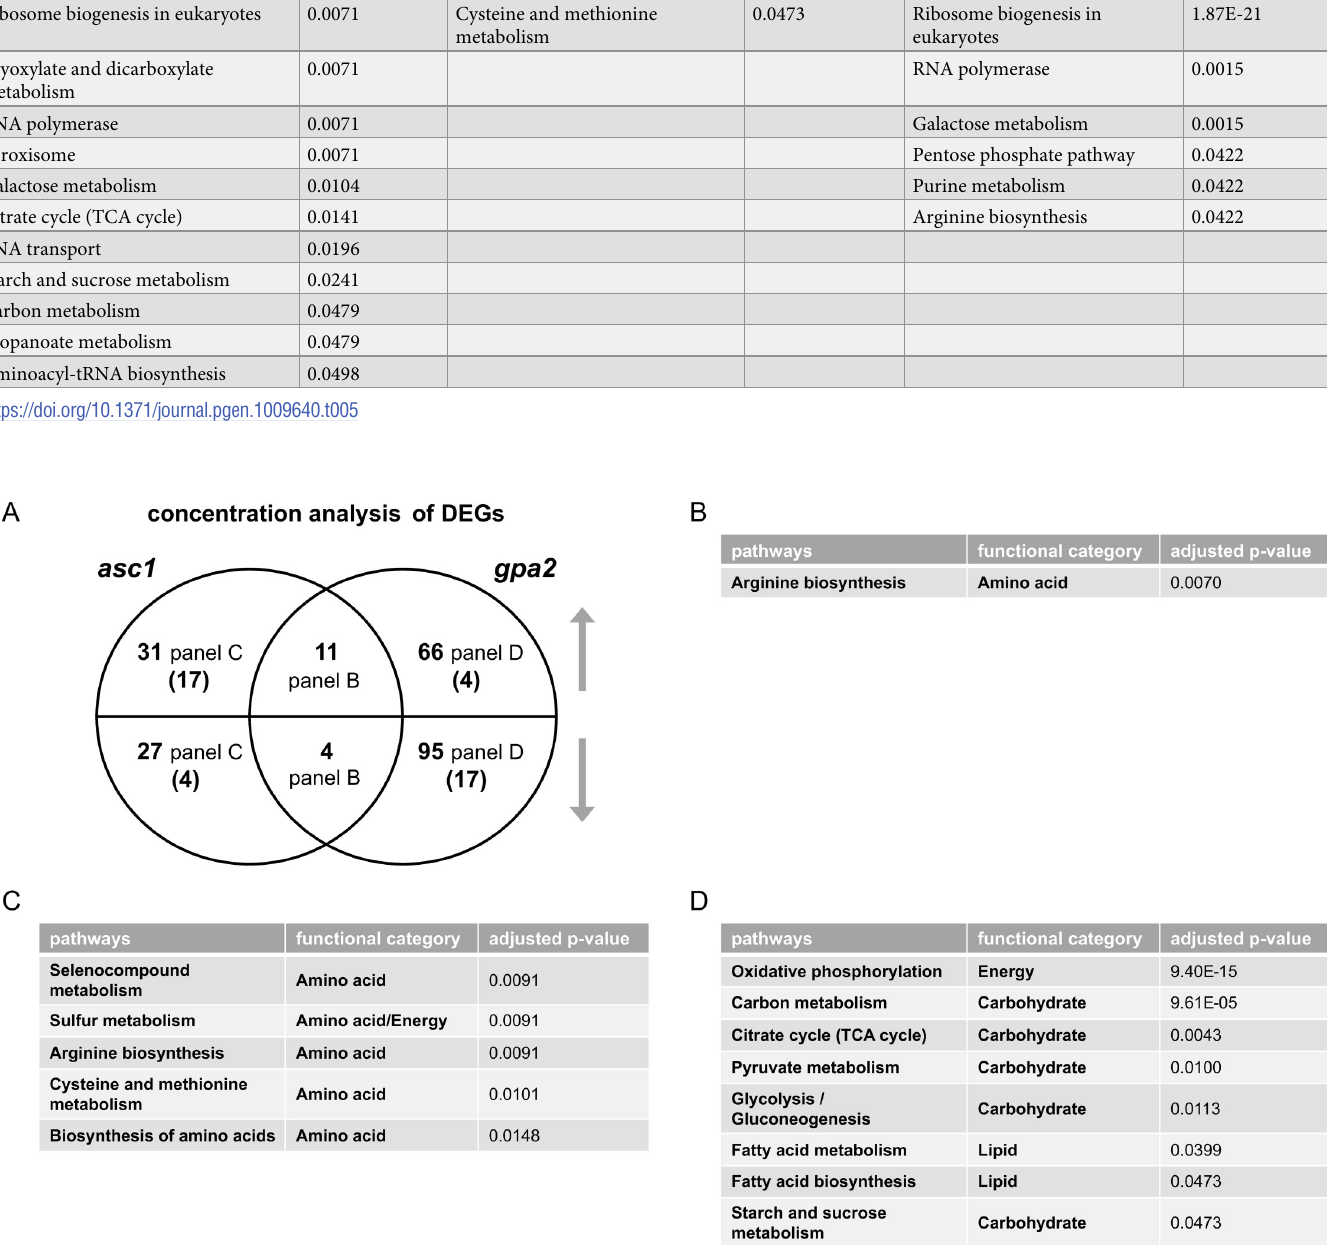
Fig 2. Concentration analysis of differentially expressed genes (DEGs) after glucose addition. A) Venn diagram of subsets of DEGs, for asc1 and gpa2 vs. wildtype, after glucose addition to 2%. Upper semicircle shows up-regulated DEGs and lower semicircle shows down-regulated DEGs. Numbers in parenthesis are shared DEGs regulated in the opposite direction, placed in the area corresponding to the direction of regulation. DEGs used for ORA analysis that are B) shared and change in the same direction; C) unique to asc1 ; D) unique to gpa2 . Listed are all pathways and their functional categories with adjusted p-value < 0.05.